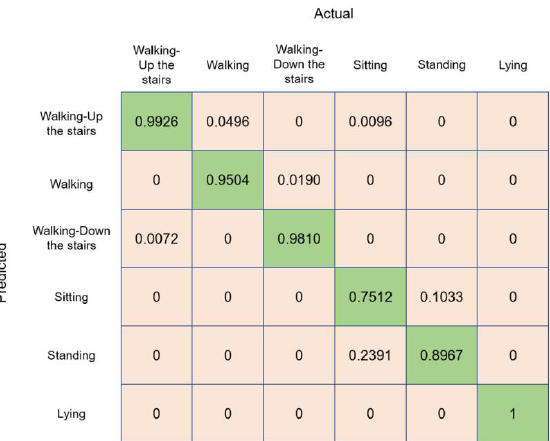
Figure 6. Normalized confusion matrix of the Generalized Linear Model (GLM).